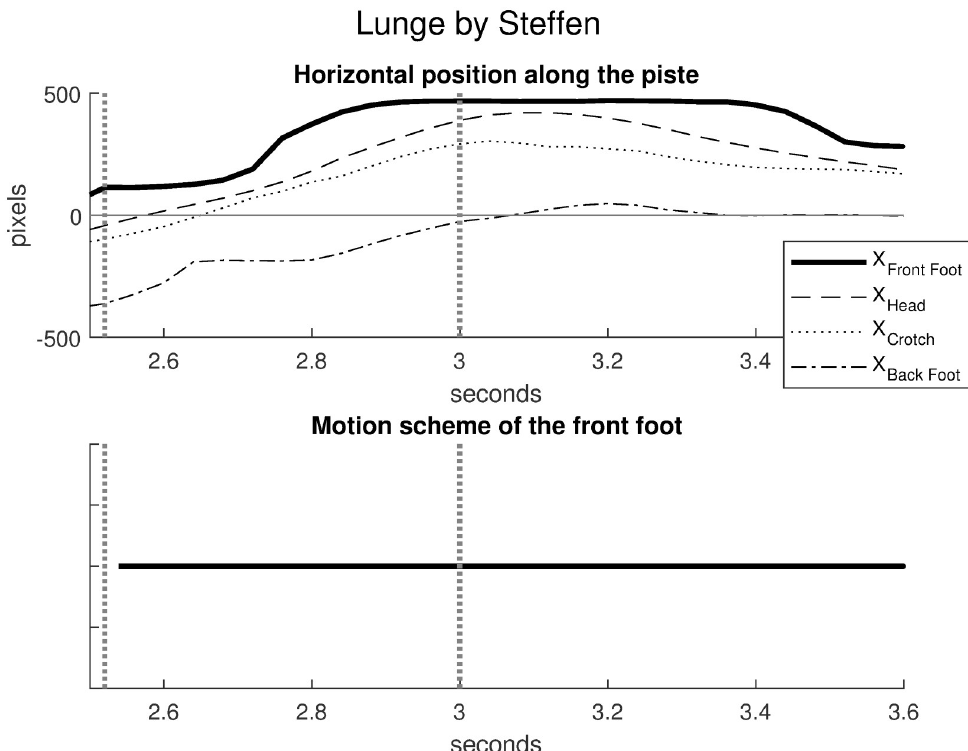
Fig 26. Steffen’s lunge in the duel Steffen-Grumier. The touch at 3 seconds and the start 0.5 seconds before the touch are represented by dotted vertical lines. The motion scheme of the front foot (bottom plot) is monotonic with respect to the head, the crotch and the back foot. Source of the original video: